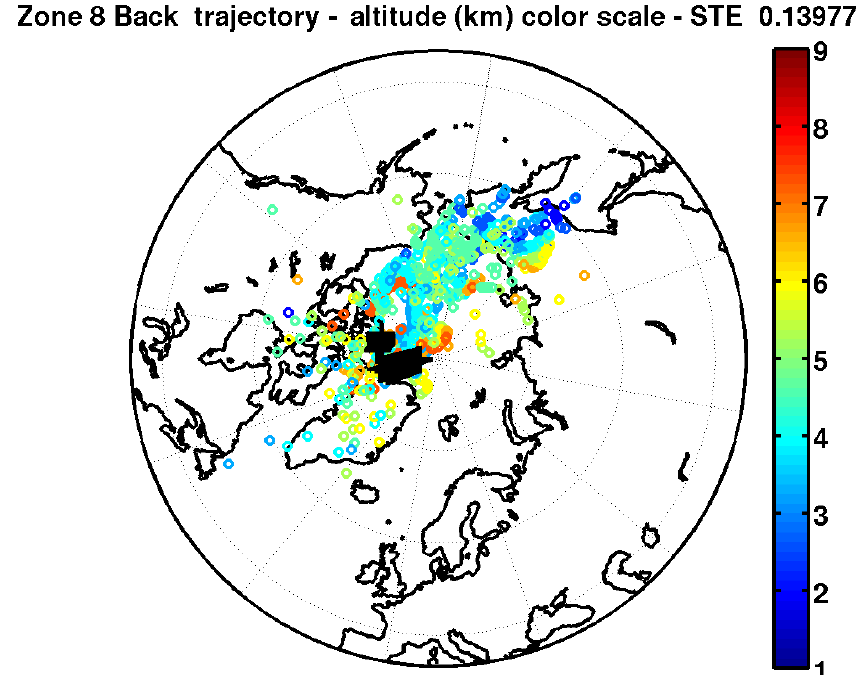
Figure 13. Same as Fig. 12 for the observations at latitudes > 80 ◦ N in zone